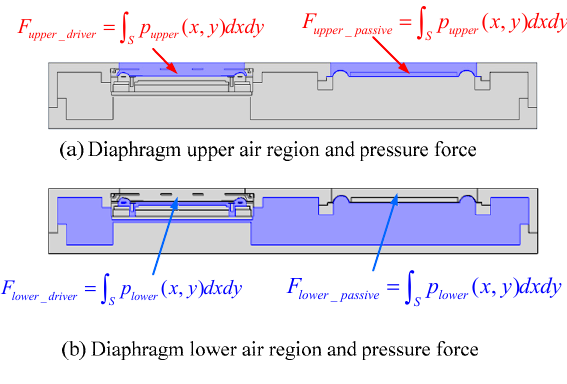
Figure 5. Air region and air-pressure force.